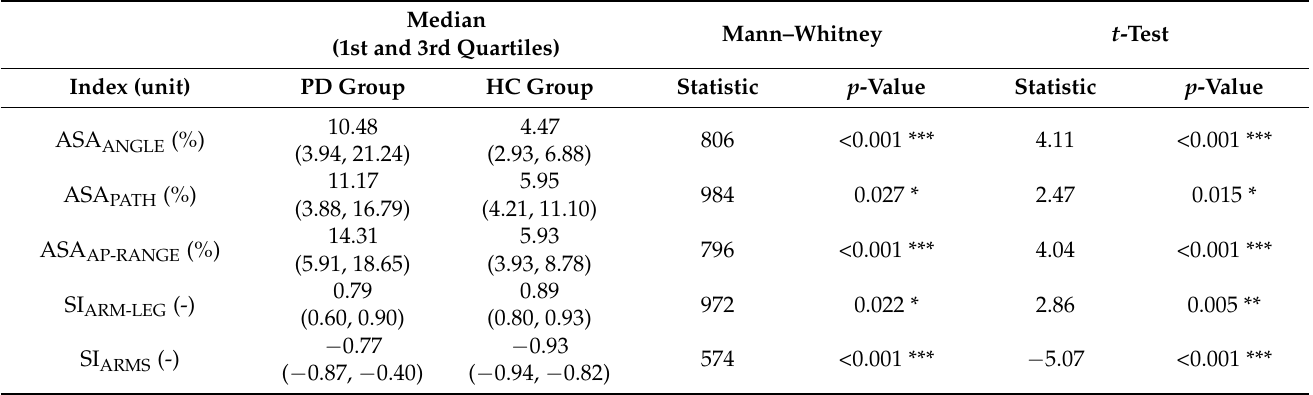
Table 5. Median and quartiles (first and third) relative to asymmetry and synchrony indices for PD and HC groups, with test statistic, p -value, and significance